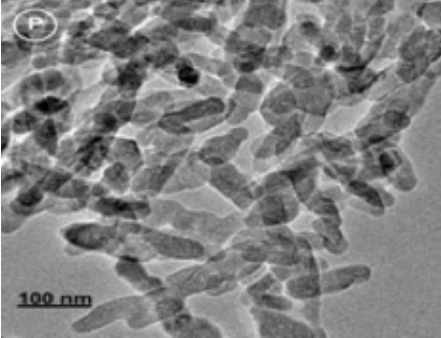
Figure 1. Transmission electron microscopy (TEM) of phosphorus nanoparticles.